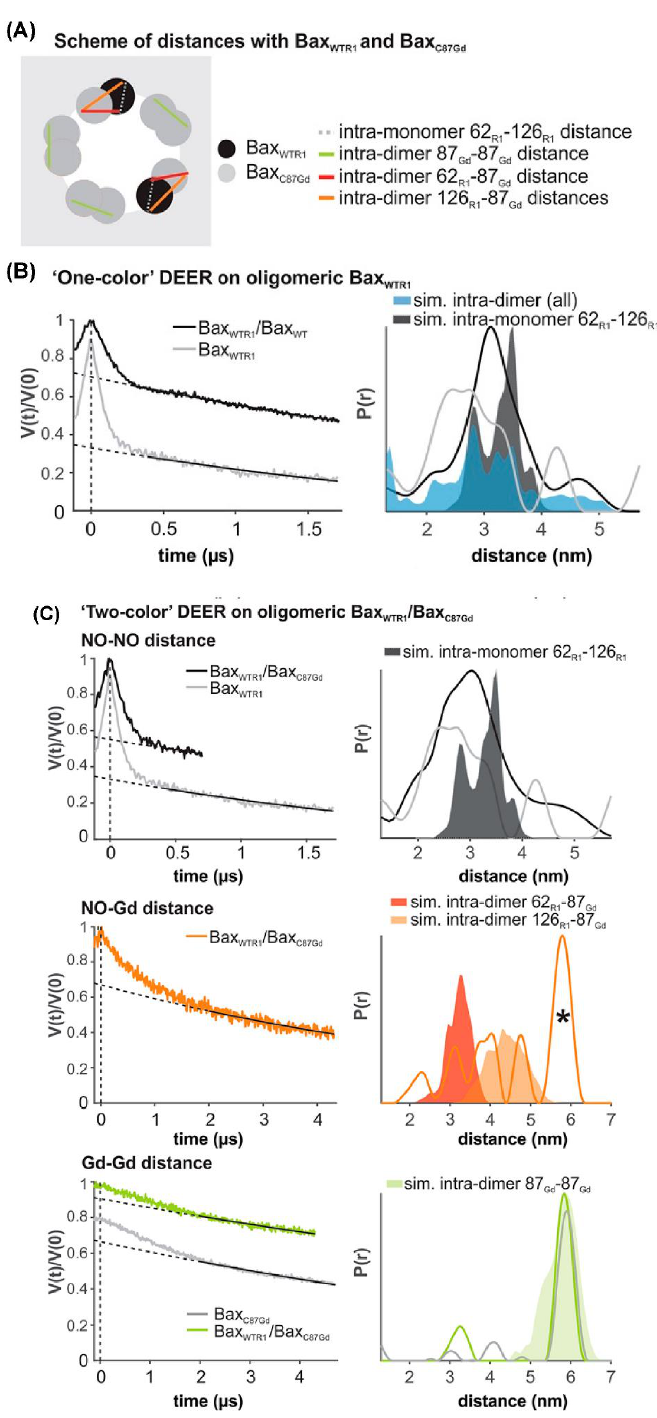
Figure 9. DEER distance measurements on oligomeric Bax with orthogonal spin labels. ( A ) Schematic of the expected distances. ( B , C ) Primary data with background function (left) and time distribution (right). The shaded areas represent corresponding distance simulations based on the structures. ( B ) Active Bax WTR1 mixed with 3-fold excess unlabeled Bax WT (black) compared to the undiluted Bax WTR1 (grey). ( C ) Upper panel, NO-NO DEER on active Bax WT with 3-fold excess of Bax C87Gd compared to the Bax WT alone (grey). Central panel, NO-Gd DEER on the samples. The asterisk highlights a possible channel cross-talk signal. Bottom panel, Gd-Gd DEER on the sample (green) compared to Bax C87Gd alone (Grey). (Adapted from [177] with